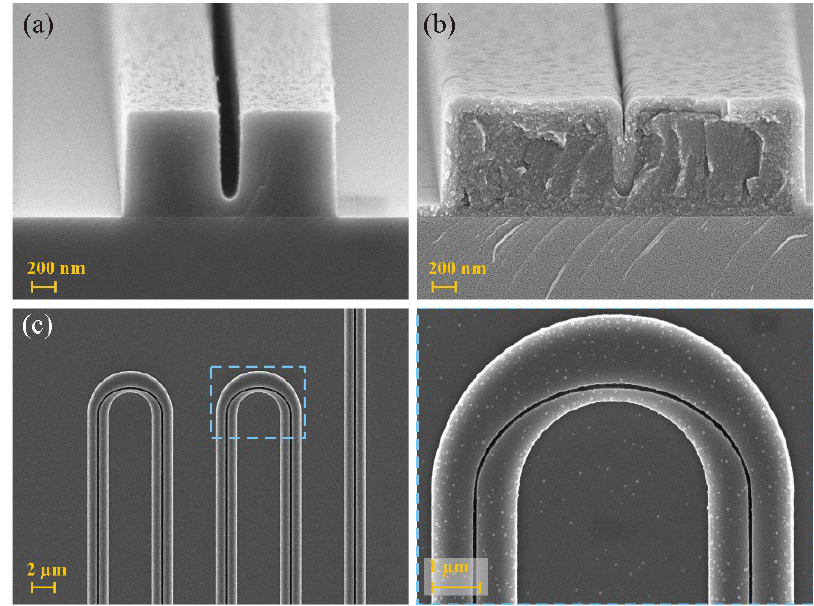
Figure 8. Scanning electron microscope pictures of examples of fabricated waveguide. ( a ) Cross section before ALD coating along the actual waveguide section. ( b ) Cross section after ALD coating along the tapered section of the waveguide. ( c ) Top view of a multi-bend waveguide with a zoomed-in section on the bend before TiO 2 deposition.